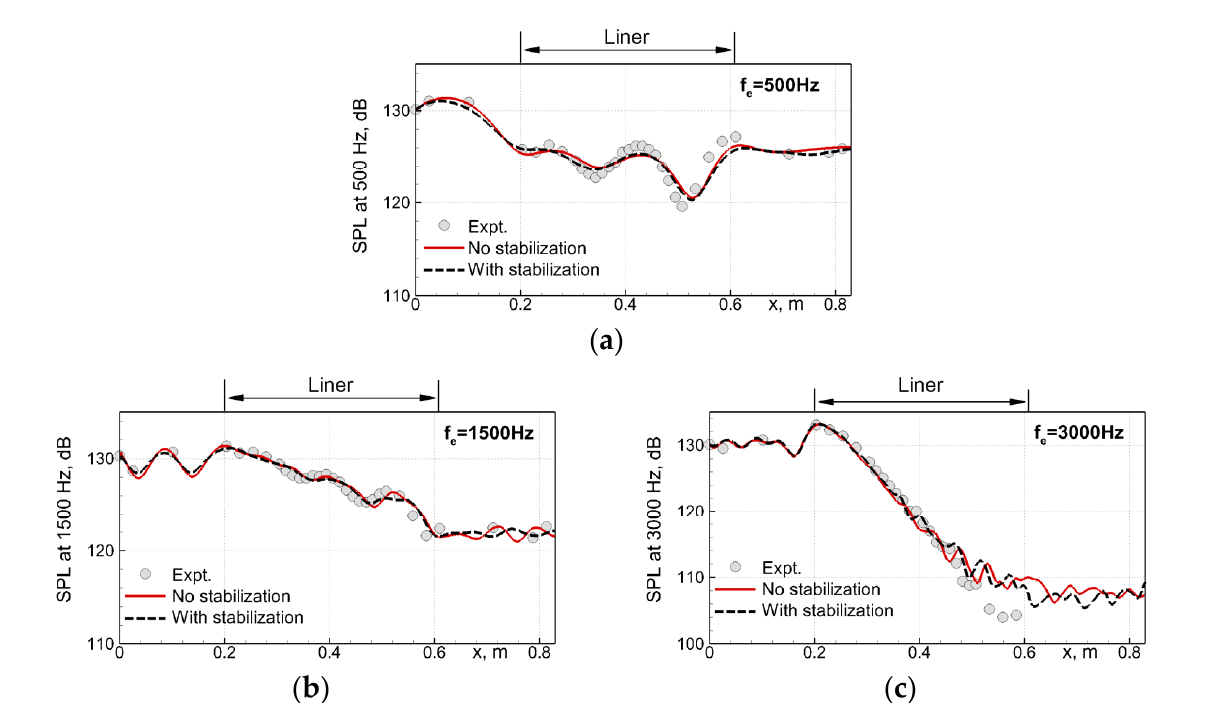
Figure 22. E ff ect of stabilization (10) on computed SPL distributions along the GIT wall at non-resonant forcing frequencies. ( a ): f e = 500 Hz; ( b ): 1500 Hz; ( c ): 3000 Hz.